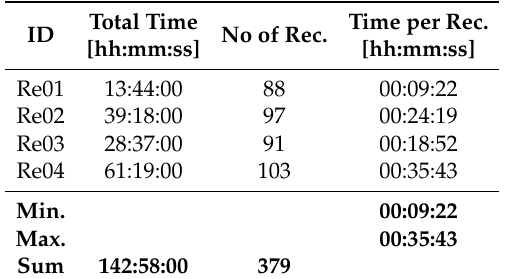
Table 6. Revision effort of all